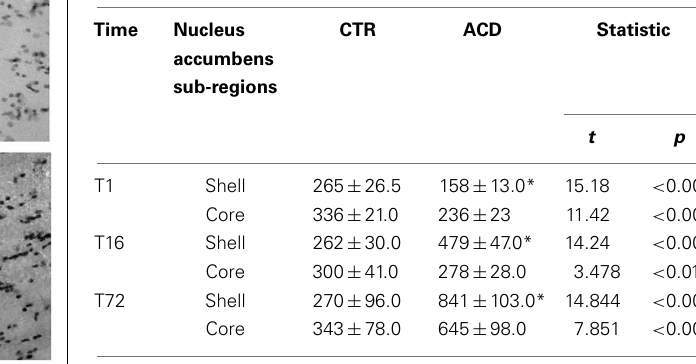
Table 3 | Number of NPY-positive neurons expression in nucleus accumbens shell and core, inACD and in control rats at different times following the last intragastric infusion (T1,T16,T72)